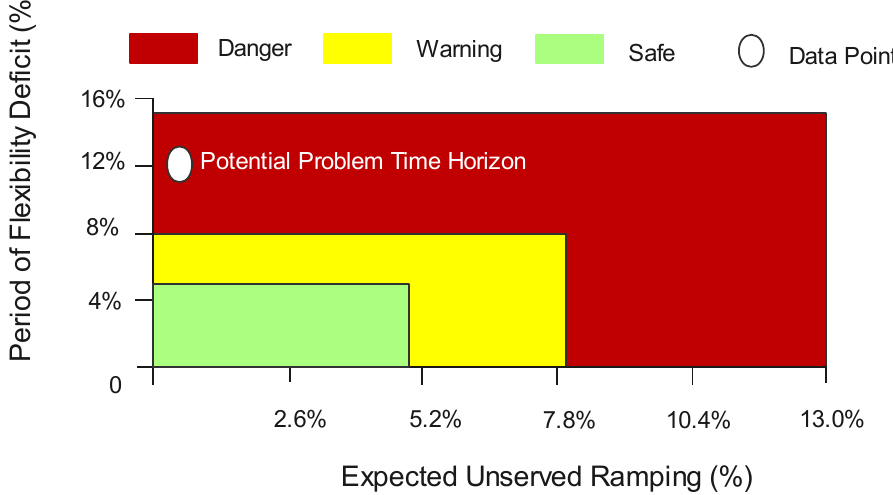
Figure 6. Number of PFD against the sum of magnitudes of the deficits over time horizon of one year, illustrating the flexibility wellbeing